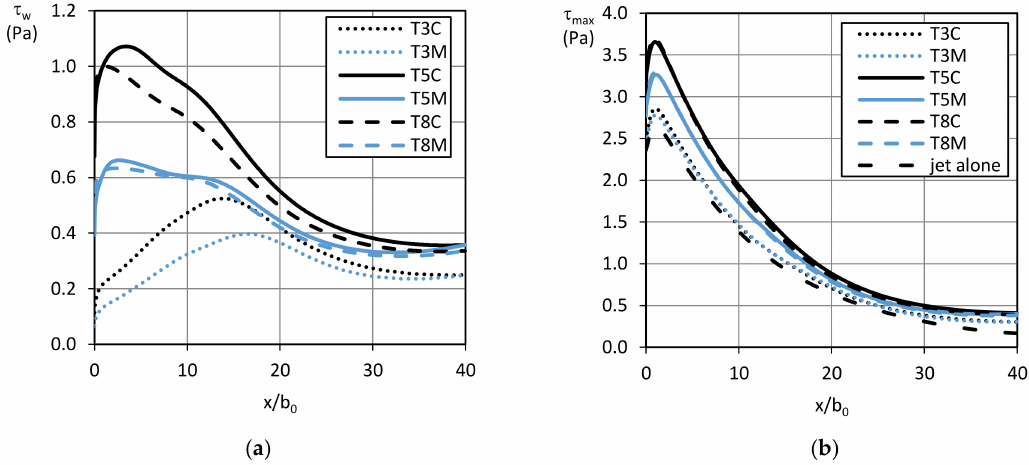
Figure 14. Bottom shear stresses along the jet centerline: ( a ) τ w in the performed simulations; ( b ) comparison between the maximum bottom shear stress of the jet alone with those computed in the interactions with